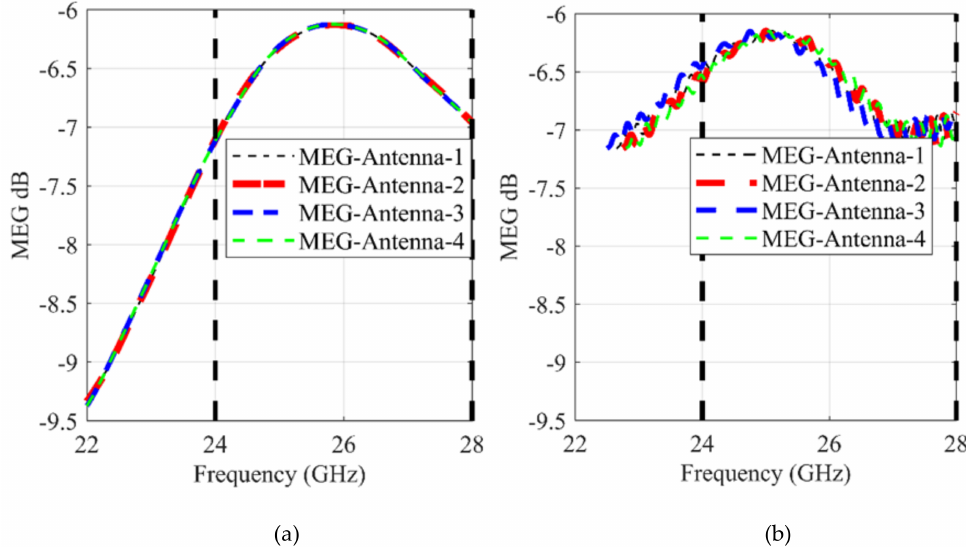
Figure 21. The measured and simulated MEG for mmWave MIMO configuration: ( a ) simulated MEG; ( b ) measured